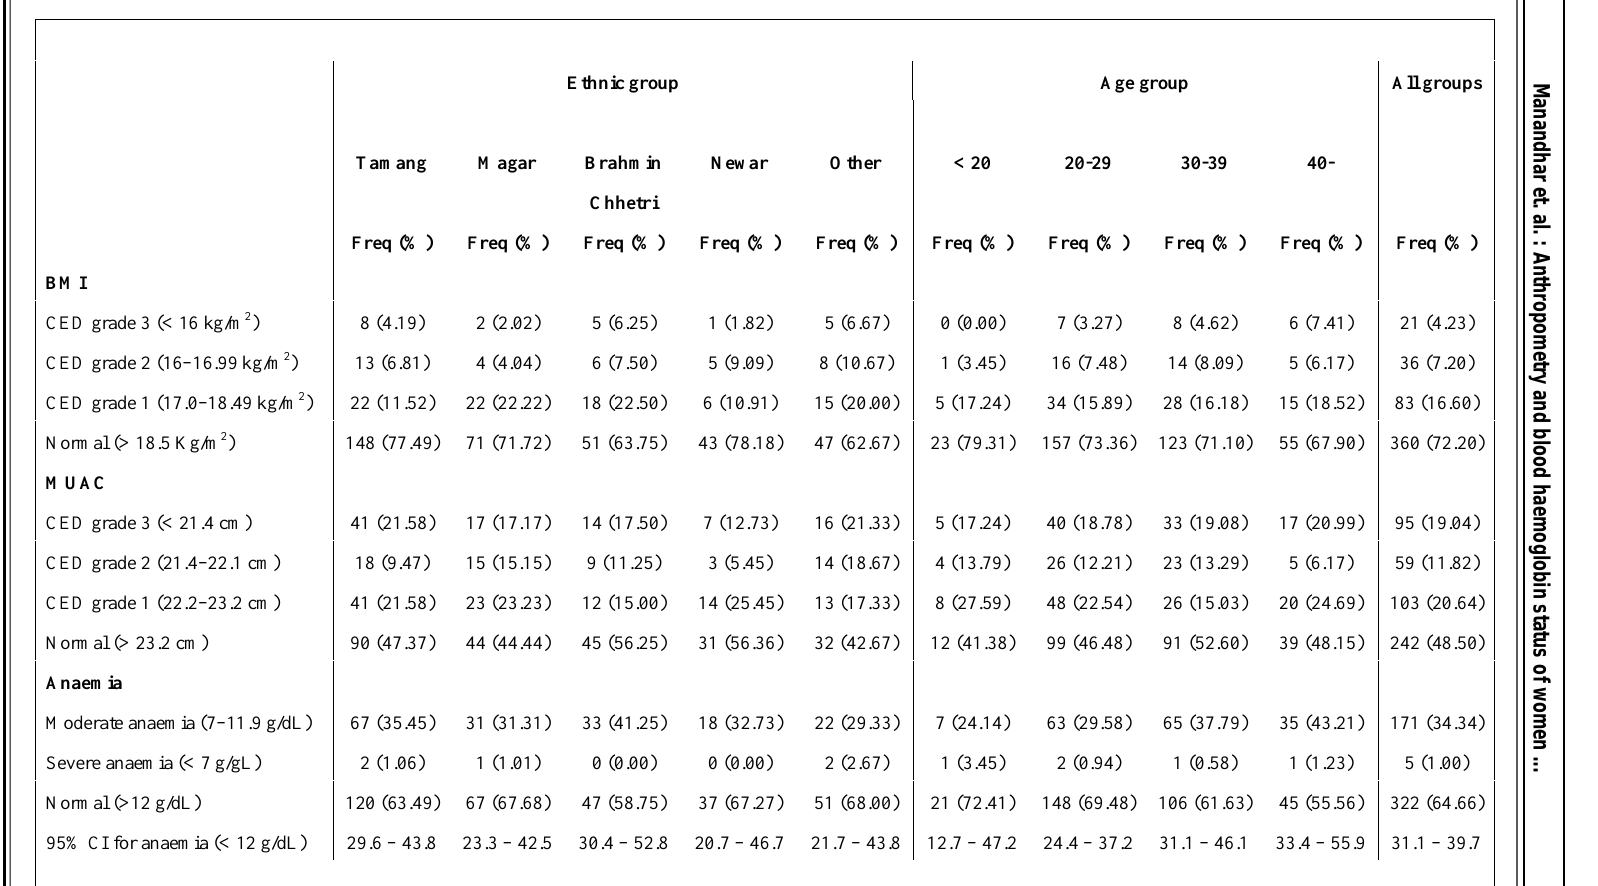
Table 2 : BMI, MUAC and anaemia ranges in the sample, stratified by ethinic group and age